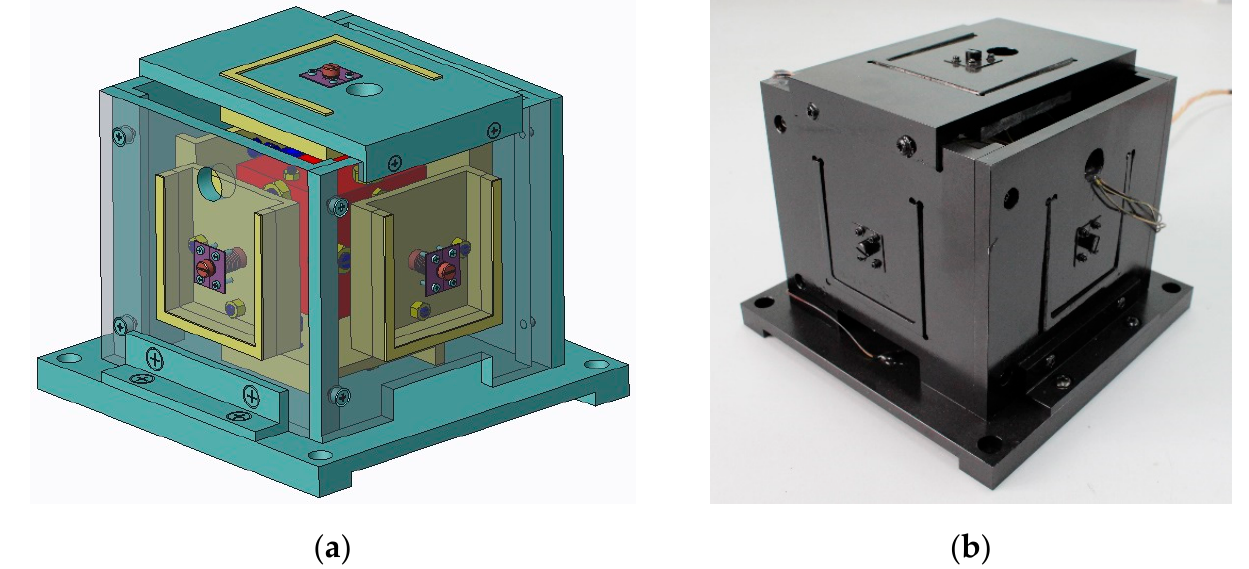
Figure 1. Prototype of the six-axis accelerometer: ( a ) Digital prototype of six-axis accelerometer; ( b ) Physical prototype of six-axis accelerometer.